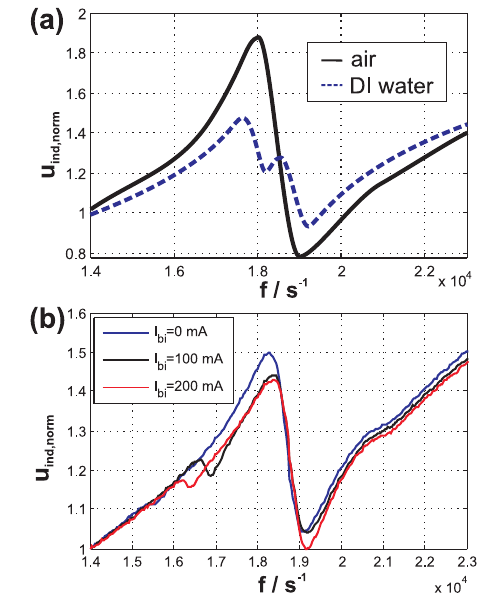
Figure 6. Normalized induced voltage over the excitation frequency, comparing the vibration in air and in DI water, see (a). In (b), the frequency response for the vibration in air is analyzed for the case that a pre-stress is applied to the foil by means of a bias current on the centered electrode path. Figure 7. Amplitude (a) and phase (b) of the frequency response of the double-membrane sensor for various test liquids.